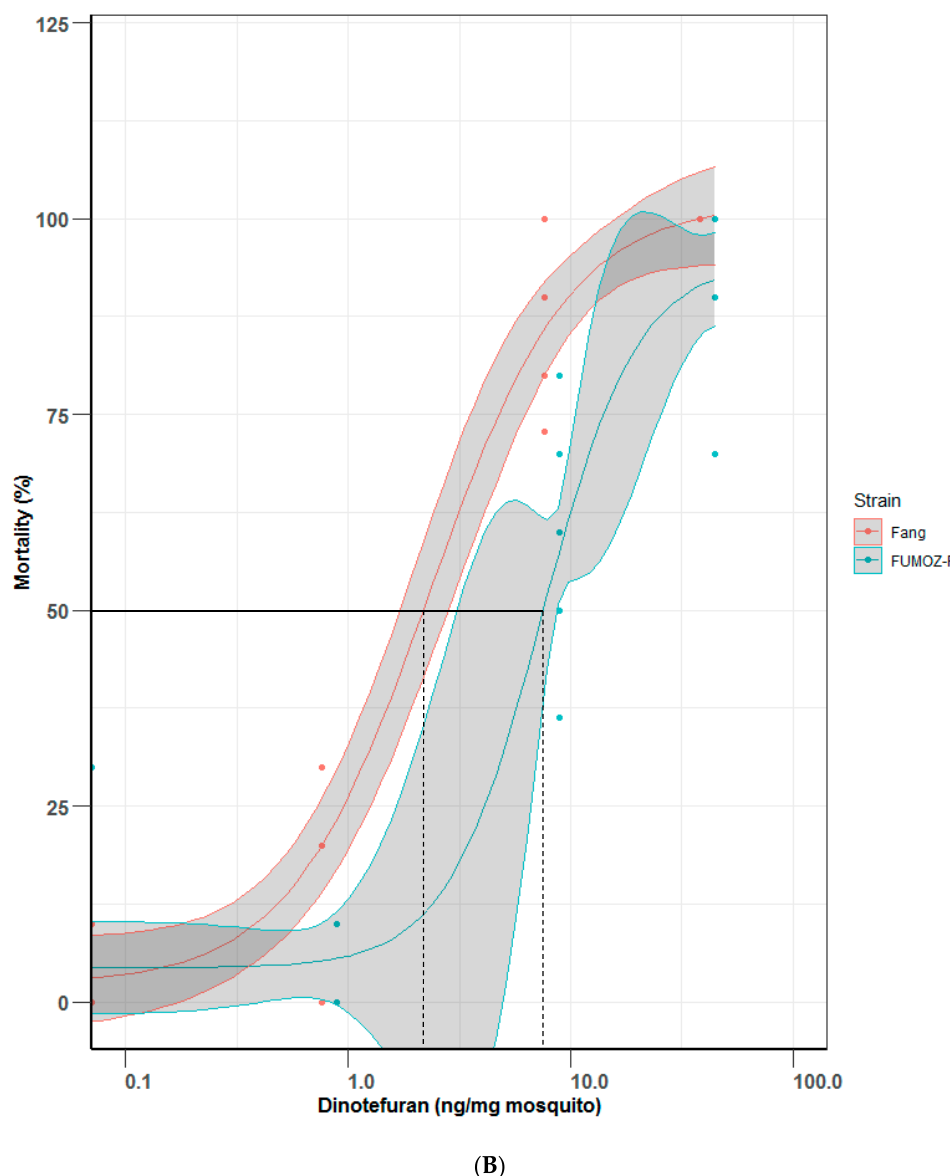
Figure 4. Mortality comparisons between ( A ) Kisumu and VK7 2014 strains and ( B ) Fang and FUMOZ-R strains in a topical application bioassay. Central lines of each curve represent the dose response of each species. Black lines indicate LD 50 values on both graphs; red lines show mortality curves of the insecticide susceptible strains of each pair of strains (Kisumu and Fang); blue lines show data for insecticide-resistant strains (VK7 2014 and FUMOZ-R). Shaded areas of each curve represent 95% CI values, generated by R software using the ggplot2 package [13]. ( A ) omits data for VK7 2014 treated with 136 ng per mg of mosquito, this gave 100% mortality with no variance as did the highest represented range (54 ng per mg of mosquito, refer to Supplementary Material) and so was removed for clarity.